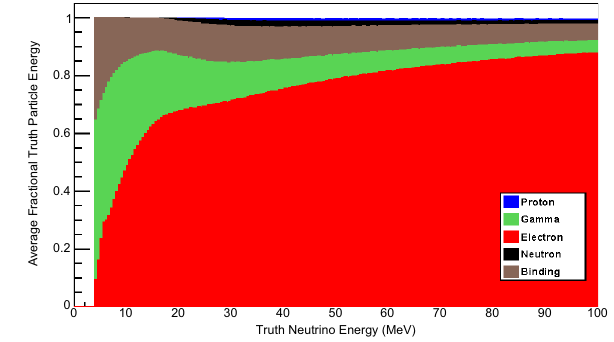
Fig. 6 Fraction of incident neutrino energy going to each final-state particle type in the MARLEY simulation as a function of neutrino energy.“Bindingenergy”representsthedifferenceinmassoftheinitial- and final-state nuclei, representing the kinematic threshold for the CC